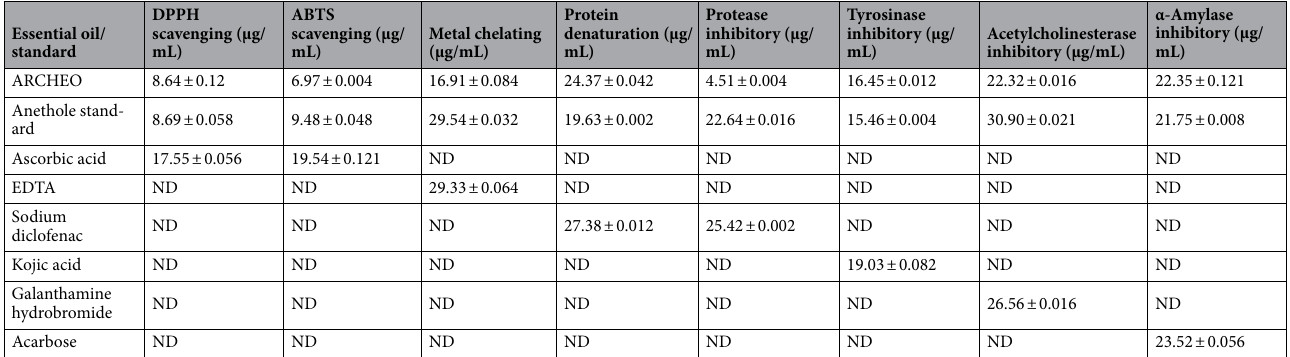
Table 3. 50% Effective concentrations (EC 50 ) determination values for pharmacological activities of ARCHEO and standards using XLSTAT software. ARCHEO anethole rich C. heptaphylla essential oil, ND not determined.